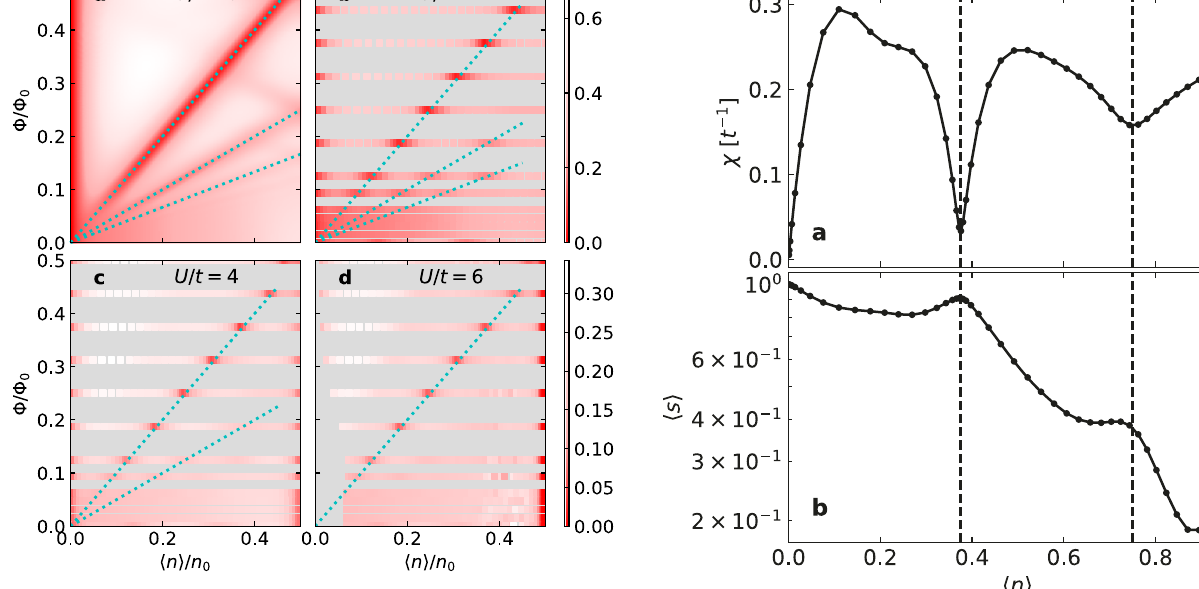
Fig. 2 Wannier diagrams. Wannier diagrams a in the non-interacting system and b – d with Hubbard U / t = 2 – 6. Gray regions in b – d are parameter regions where we don't have simulation data. All plots have inverse temperature β = 5/ t . Magnetic fi eld strength is displayed as Φ / Φ 0 , and electron density is shown as 〈 n 〉 / n 0 , where n 0 is the electron density of a completely fi lled system, which in our case is 2. The system is particle- hole symmetric, so only the range 〈 n 〉 / n 0 ∈ [0, 0.5] is shown. Dotted cyan lines indicate where we expect local minima of charge compressibility to occur from the non-interacting model.